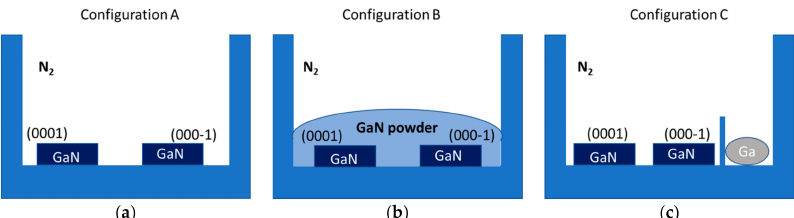
Figure 2. Three configurations for annealing HVPE-GaN samples with exposed (0001) and (000-1) surfaces: ( a ) in N 2 rich conditions; samples have direct contact only with N 2 (configuration A); ( b ) covered by polycrystalline GaN powder (configuration B); ( c ) close to Ga droplet (configuration C); the samples are placed in a crucible (represented by blue box in the figure), resistive heater and high pressure autoclave